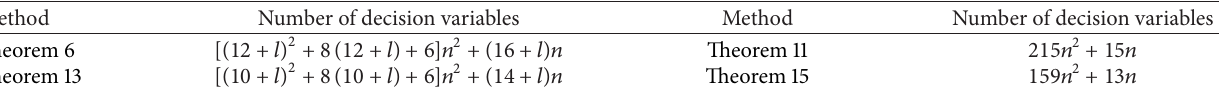
Table 8: Number of decision variables involved in the stability criteria.